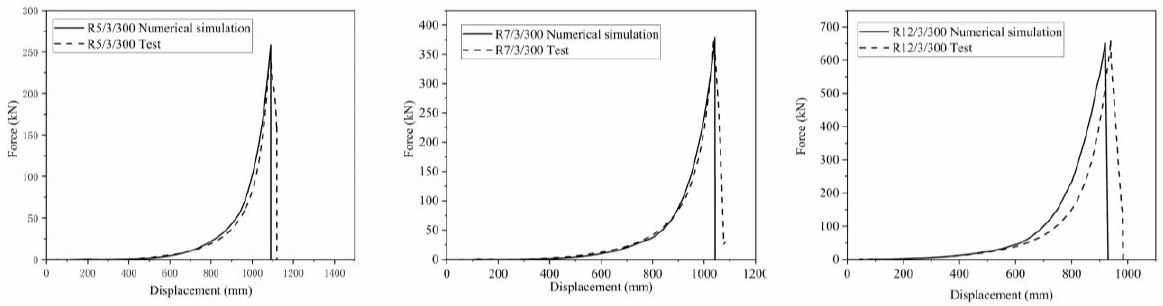
Figure 13. Comparison of experimental and numerical simulation results in the static punching test.